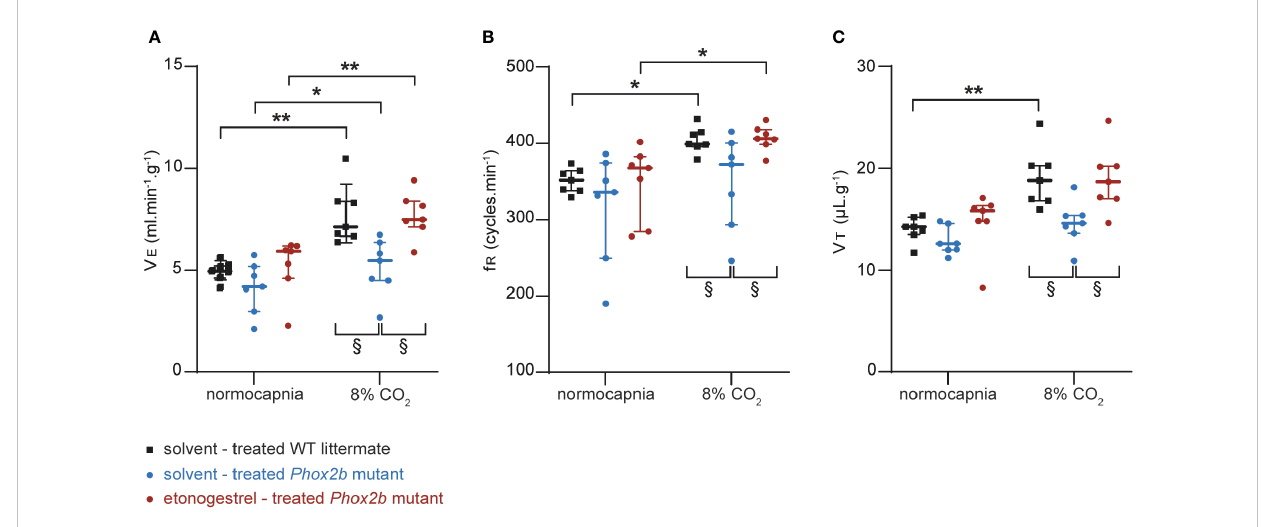
FIGURE 2 Effect of etonogestrel on the ventilation in adult male Phox2b mutant mice. Scatter plots with median and interquartile [Q1; Q3] superimposed of the minute ventilation (VE; A ), respiratory frequency (fR; B ) and tidal volume (VT; C ). *Indicates a signi fi cant difference in VE, fR or VT relative to normocapnic values (*p < 0.05, **p < 0.01; one-way analysis of variance or Friedman test followed by Benjamini, Krieger and Yekutieli ’ s multiple comparison test). § Indicates a signi fi cant difference between mice groups § p < 0.05; two-way analysis of variance test followed by Benjamini, Krieger and Yekutieli ’ s multiple comparison